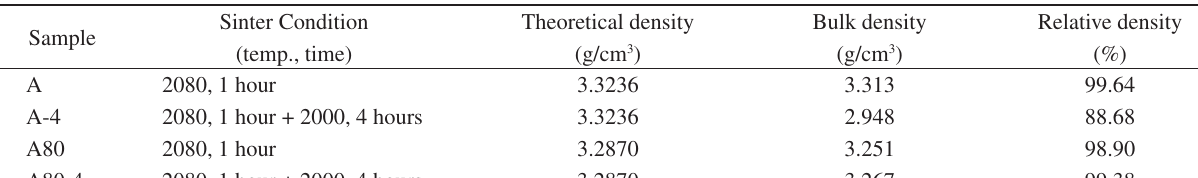
Figure 3. Notch produced by a cut with a diamond saw and tapered with a razor Table 2. Bulk and relative density of the sintered samples.